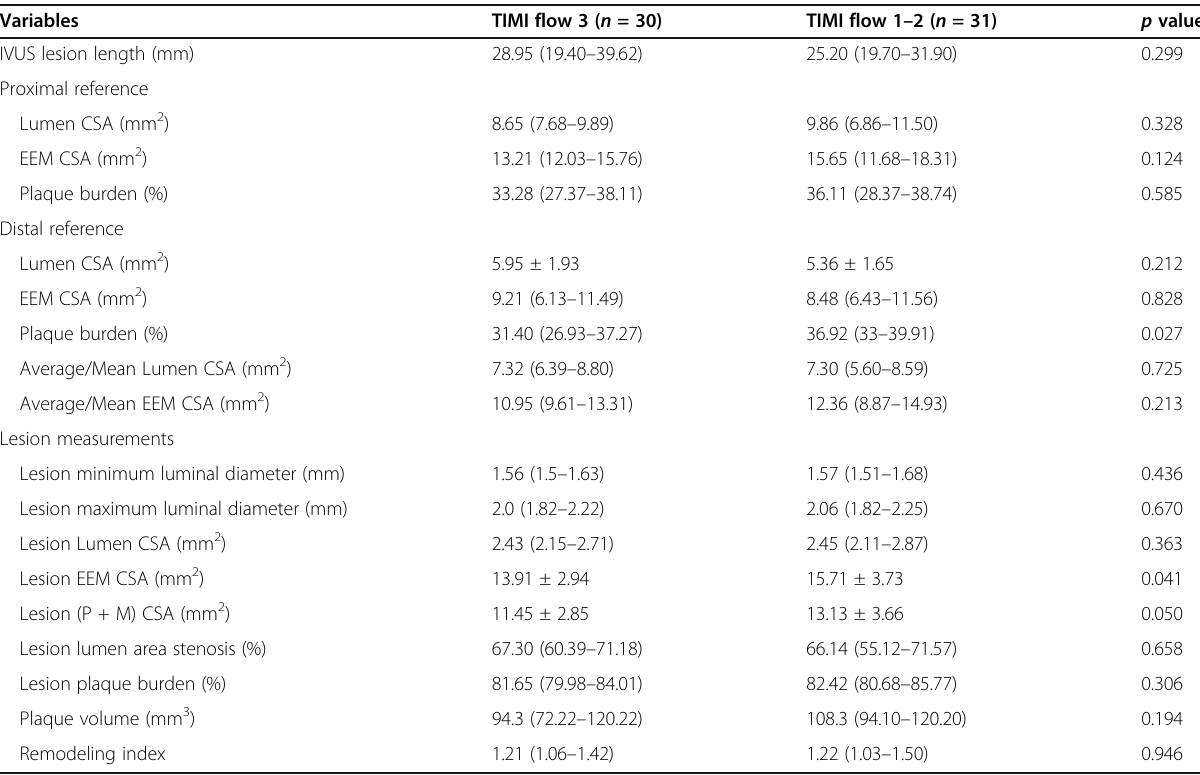
Table 3 Gray-scale IVUS findings ( n = 61)